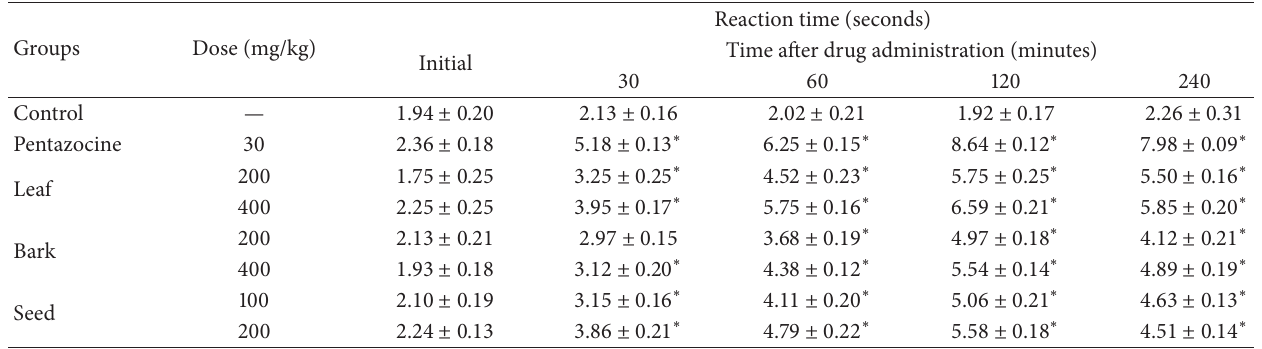
Table 3: Acetic acid-induced writhing response of ethanol extracts of C . australe in mice.